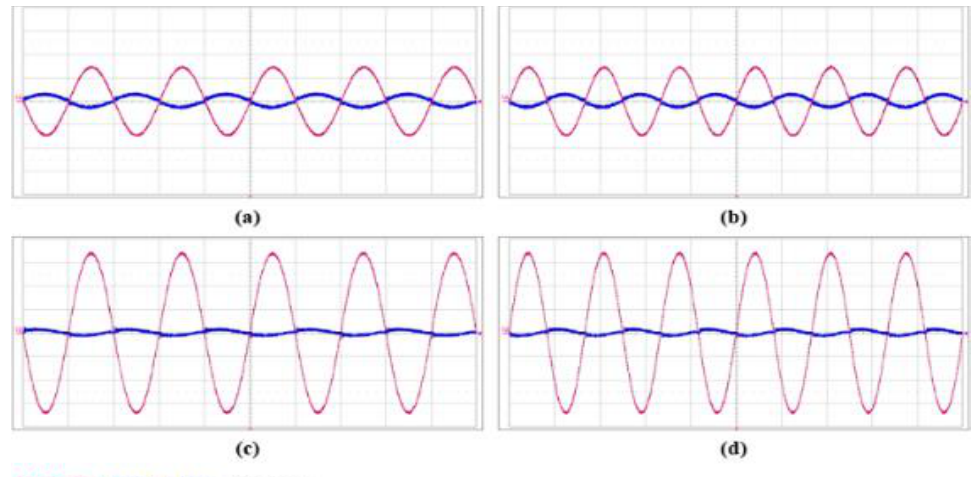
Figure 6. Input voltage waveform (red) and input current waveform (blue) ( a ) at 100 VAC/60 Hz, ( b ) 100 VAC/50 Hz, ( c ) 240 VAC/50 Hz, ( d ) 240 VAC/50 Hz.